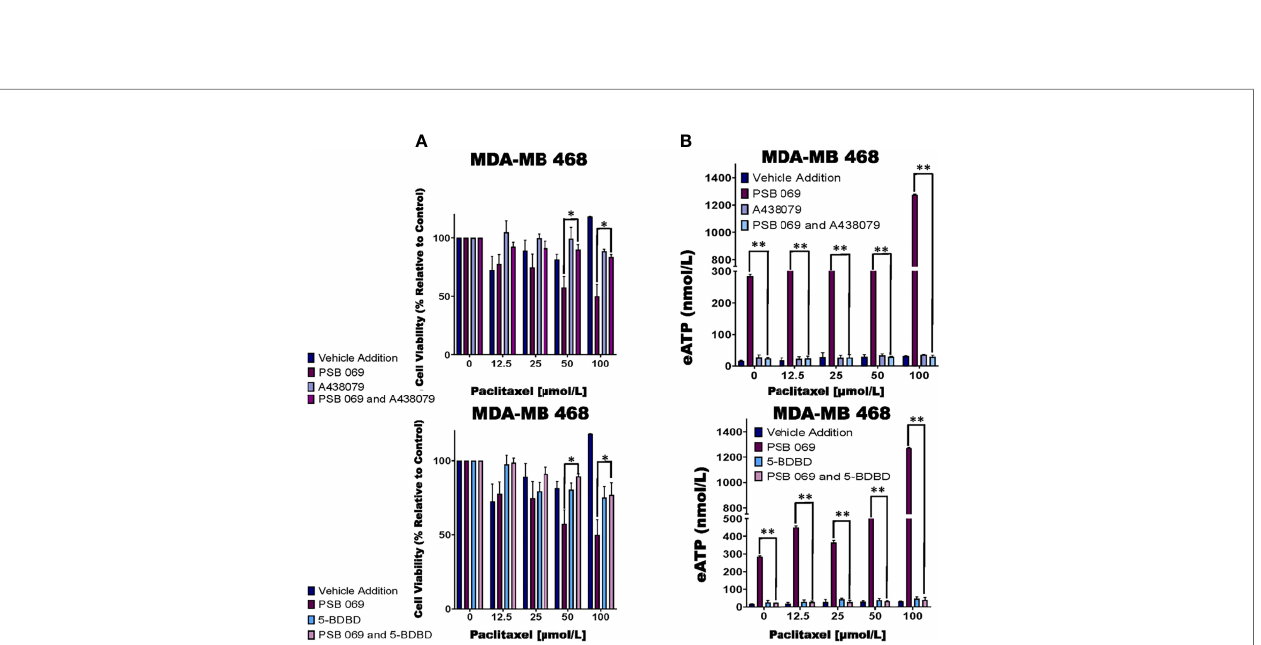
FIGURE 4 | Examining the in fl uence of P2RX inhibitors in combination with E-NTPDase inhibitor on cell viability and eATP release in paclitaxel-treated cells. (A) Paclitaxel-treated breast cancer MDA-MB 468 cell lines were treated for six hours with P2RX7 inhibitor A438079 (20 µmol/L) or P2RX4 inhibitor 5-BDBD (20 µmol/L) in the presence or absence of PSB 069 (10 µmol/L), and cell viability was measured by applying PrestoBlue HS assay. Standard deviation was calculated from three independent experiments performed in triplicate. We used the same values for both graphs for vehicle addition and PSB 069. (B) eATP concentrations were measured in the supernatants of paclitaxel-treated MDA-MB 468 cells after six hours of treatment. Standard deviation was calculated from three independent experiments performed in triplicate. We used the same values for both graphs for vehicle addition and PSB 069. The student ’ s t-test was applied to the applicable assays to ascertain signi fi cance. * represents p < 0.05 and ** represents p < 0.01 for A438079 and PSB 069 or 5-BDBD and PSB 069 when compared to PSB 069